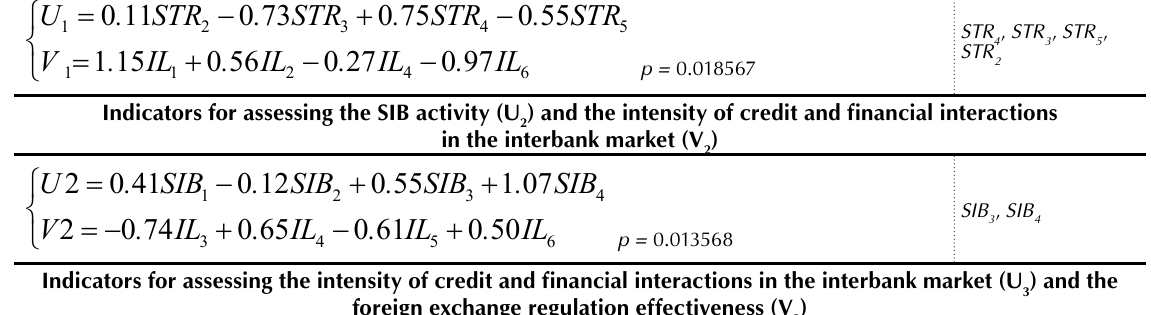
Table 3. Canonical models of relationships between the indicators for assessing the banking system financial stability Models of relationships between the indicators for assessing the banking system stability Indicators for assessing the structural changes and financial disproportions in the banking system (U intensity of credit and financial interactions in the interbank market (V